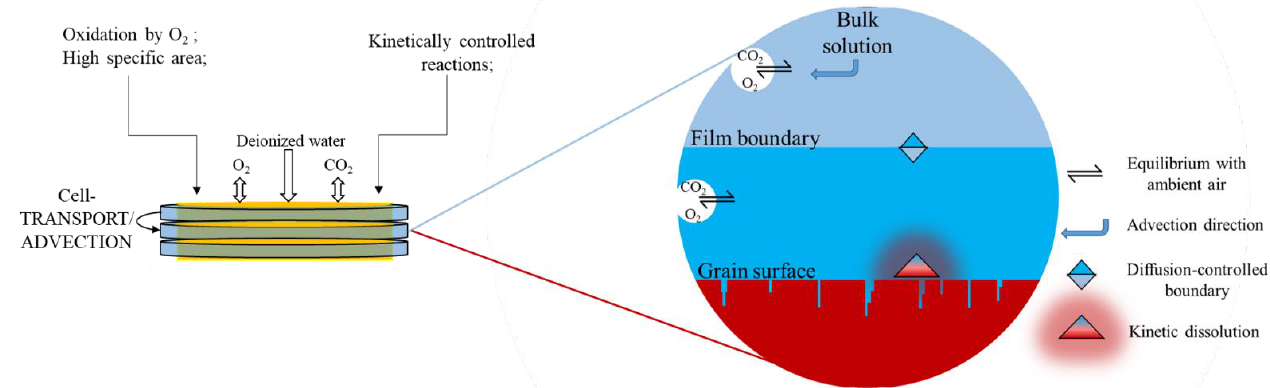
Figure 2. The conceptual model of the weathering cell tests.